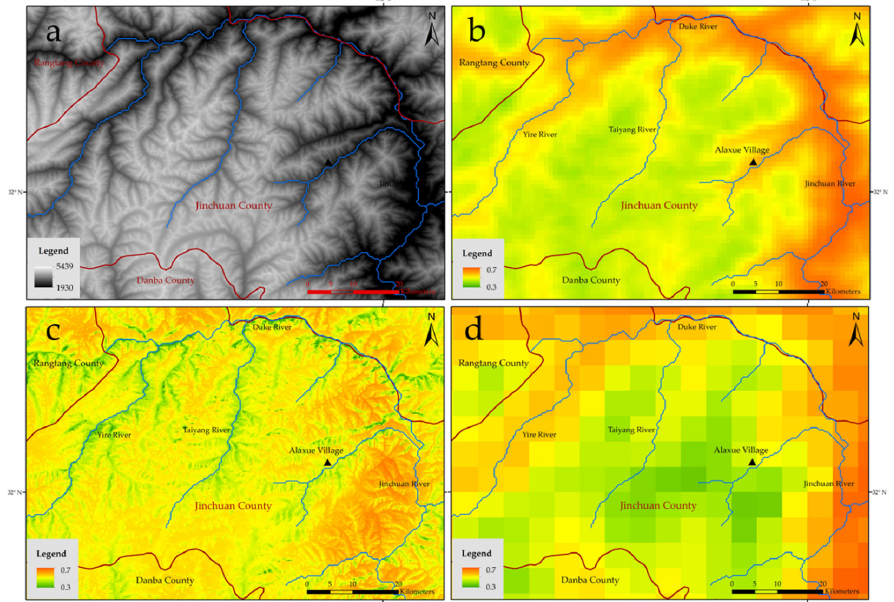
Figure 16. Distribution of PV energy (after normalization) in Jinchuan County, Sichuan Province. ( a ) DEM data. ( b ) Annual average daily total solar-radiation data. ( c ) GHI of the World Bank. ( d ) Yearly average irradiance from PVGIS.